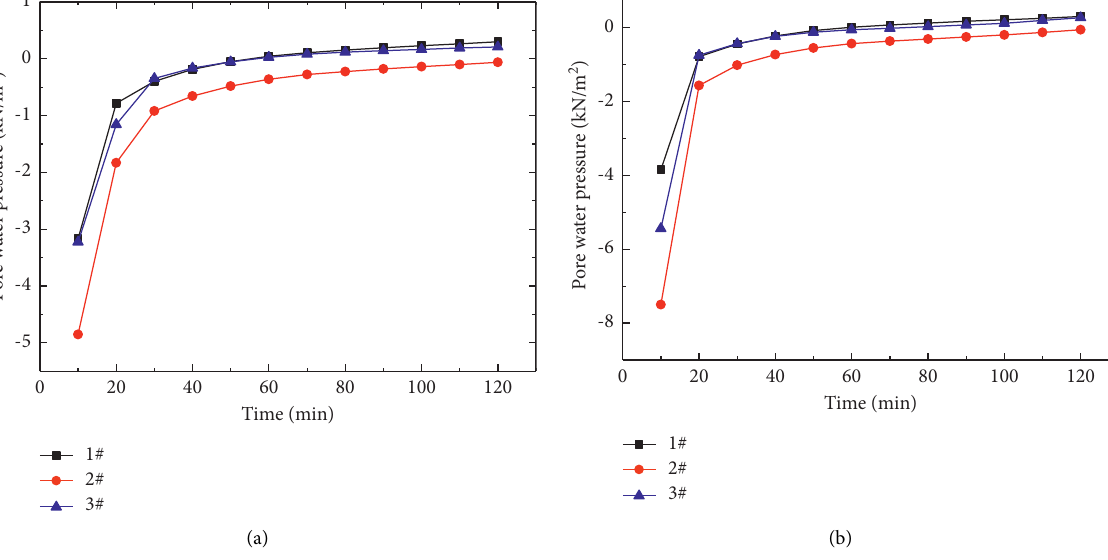
Figure 28: Pore water pressure at observation points 1–3 of (a) buildings 1–2 and (b) buildings 2–4 with seepage wells placed around buildings 1 and 2 in the numerical model.